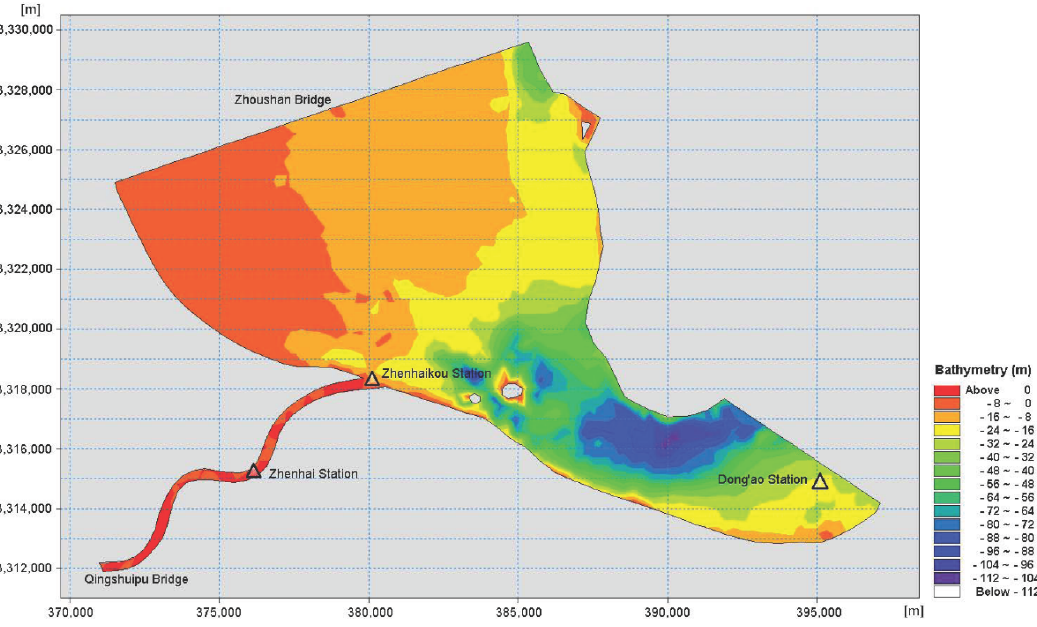
Figure 4. The bathymetric map of the study area generated by MIKE 21 (DHI, Denmark). Zhenhai, Zhenhaikou, and Dong’ao are the observation stations. Zhenhaikou, and Dong’ao are the observation